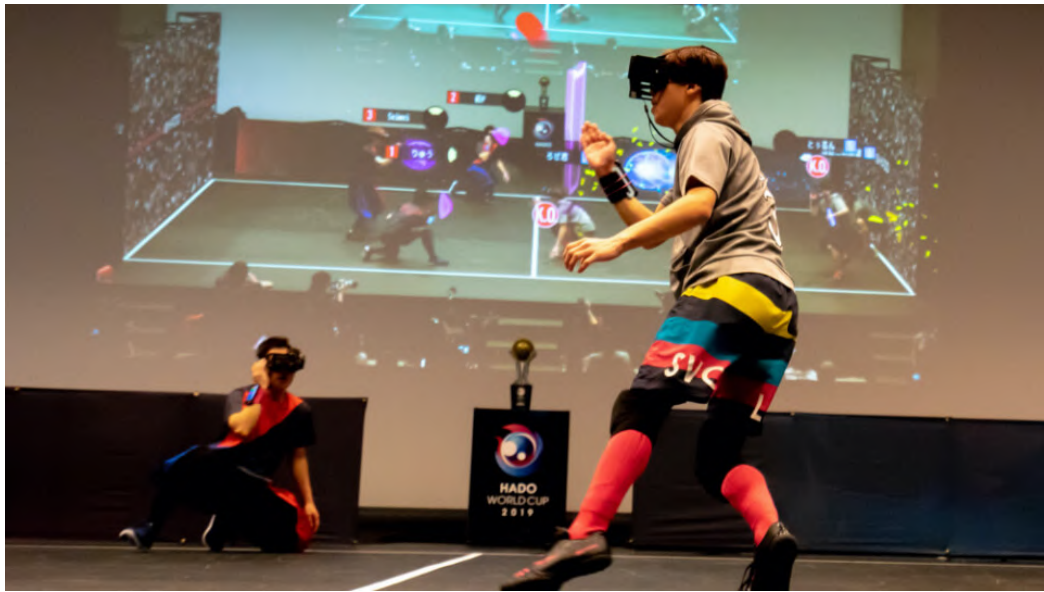
Figure 6: HADO Game Using Means by Meleap Inc.